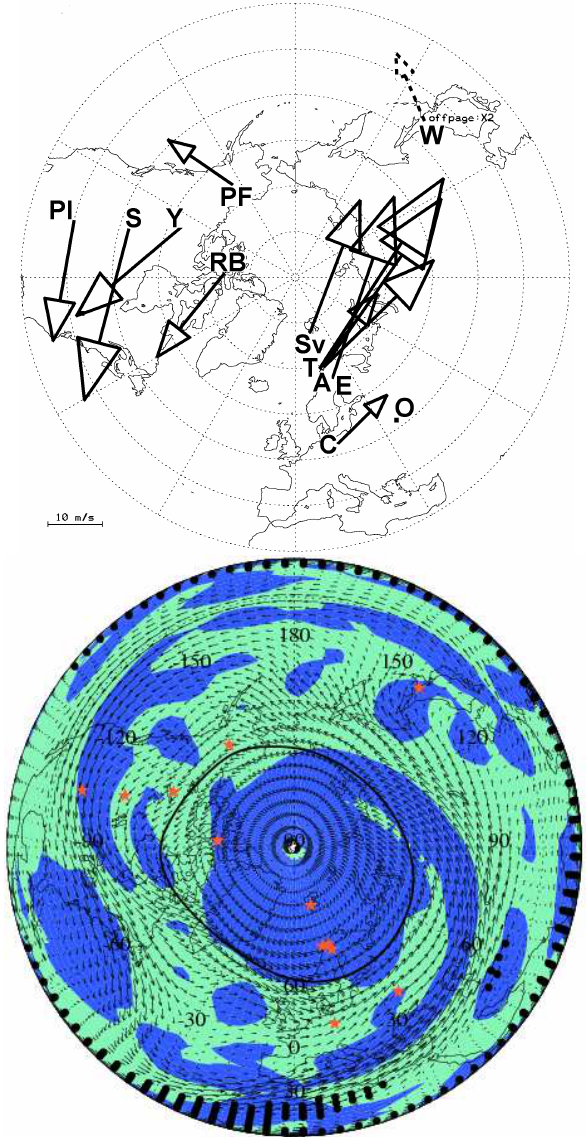
Fig. 8b. The same as Fig. 8a, but for 1 February